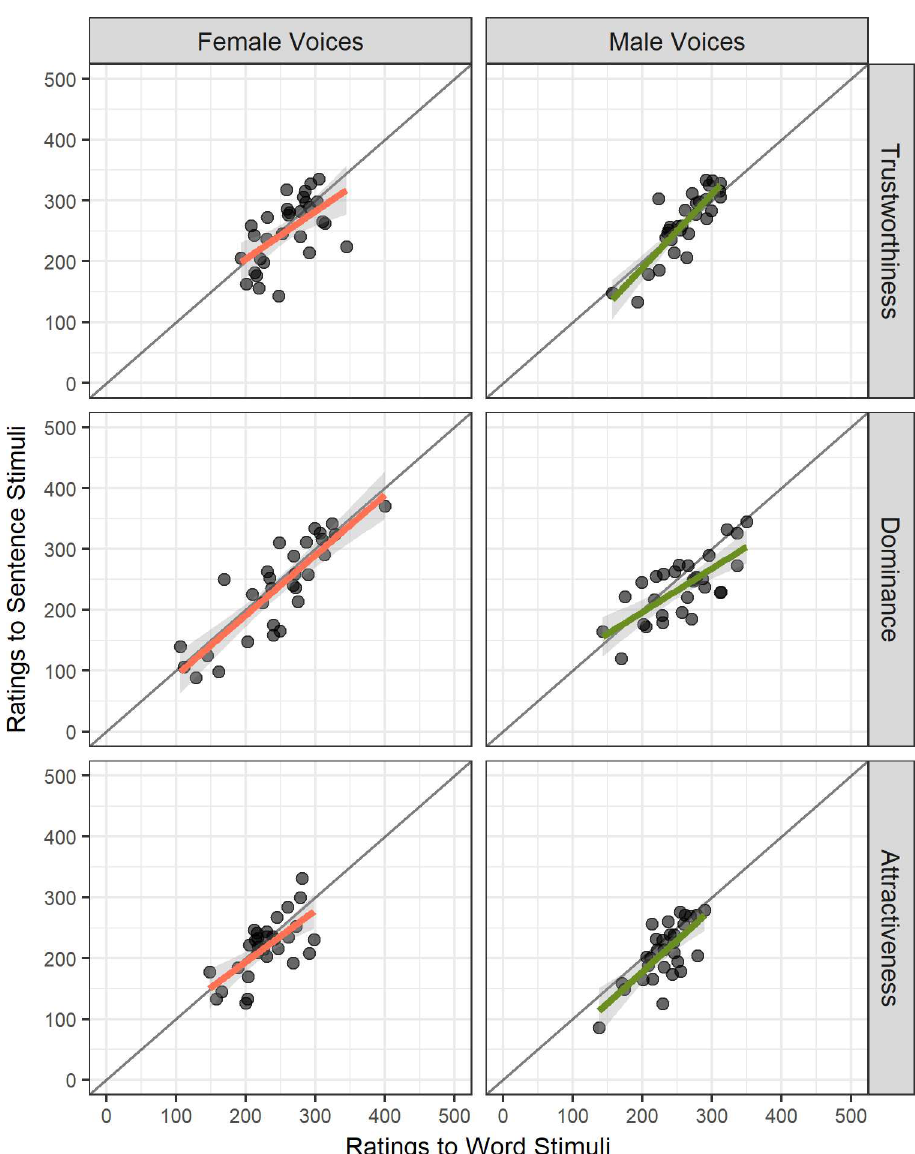
Fig 1. Scatterplot of VAS ratings for words versus sentences in female and male voices for trustworthiness (top), dominance (middle), and attractiveness (bottom panel). Female Voices (left) and regression slope (Orange); Male Voices (right) and regression slope (Green); each dot represents a single voice; grey line represents r = 1.